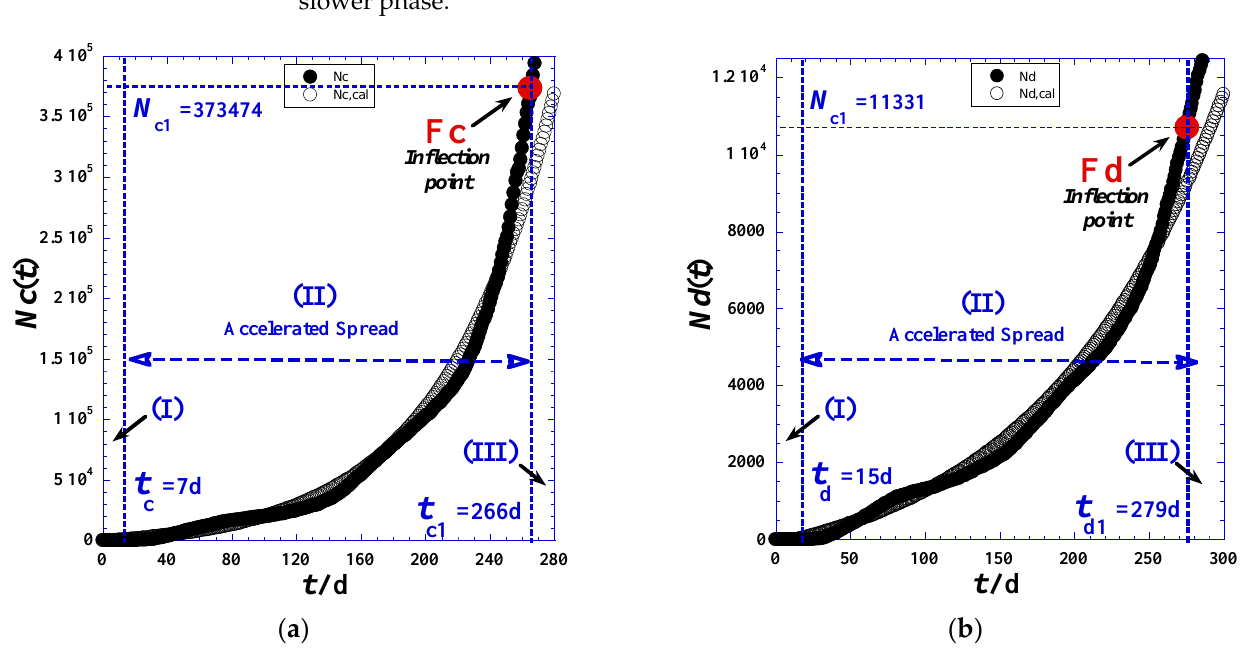
Figure 3. ( a ) The total reported cases N c ( t ) for the first 200 days of the pandemic in Romania, the accelerated phase (II) using Equation (3). ( b ) The total reported deaths N d ( t ) for the first 200 days of the pandemic in Romania, the accelerated phase (II) using Equation